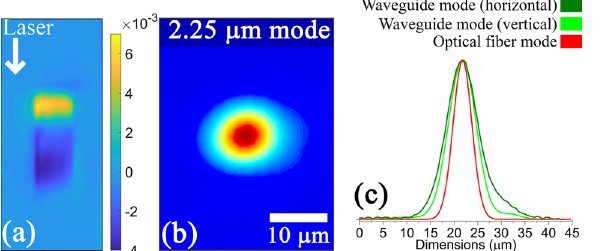
Figure 5. ( a ) Refractive index profile, ( b ) 2.25 μm laser mode and ( c ) its vertical and horizontal line profiles of the waveguide written in the 45HfF 4 -10ZrF 4 -45BLAN glass. DIC image and writing parameters as in Fig. 4.